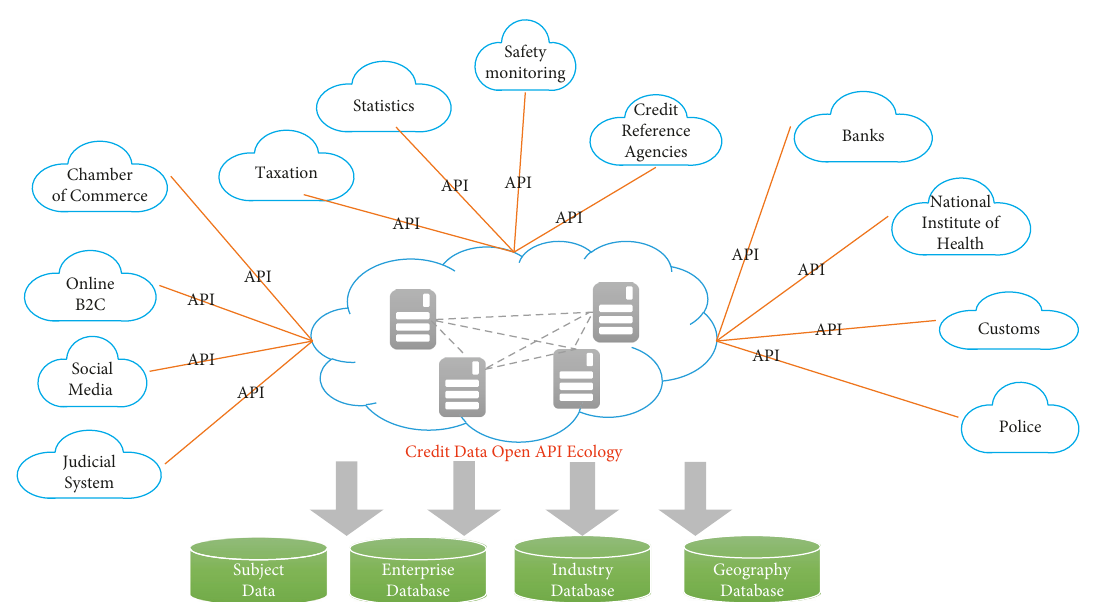
Figure 3: Open ecology of credit data with API as the